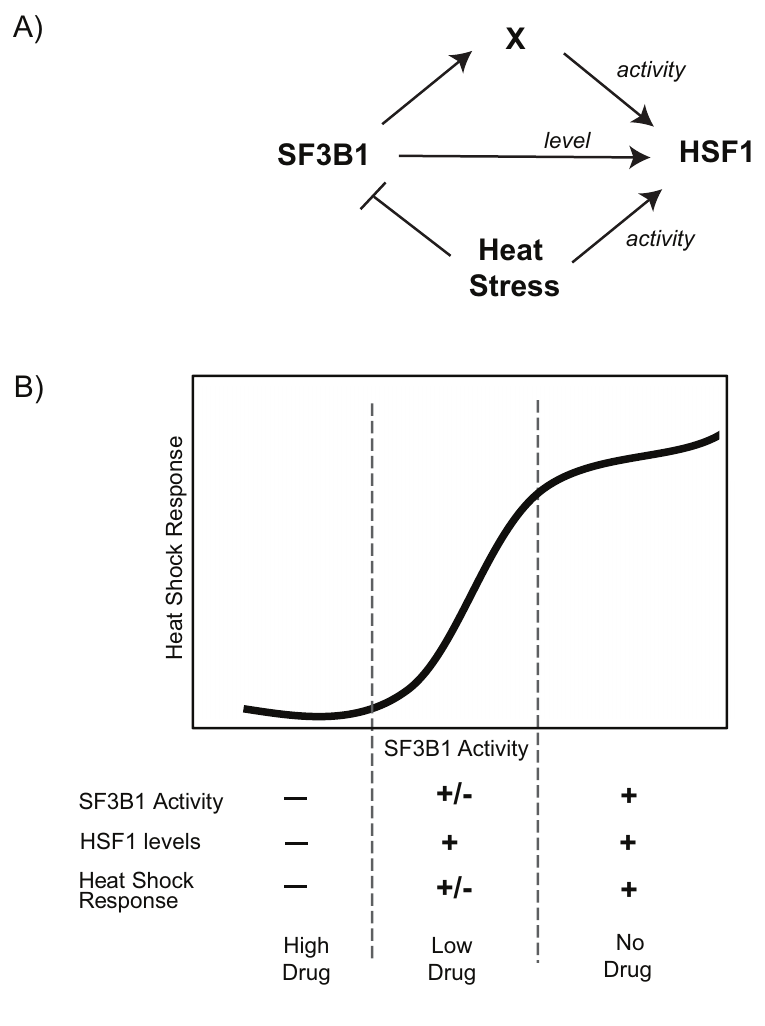
Fig 6. Model. (A) Model figure indicating the role of SF3B1 in regulationof the heat shock response. The central arrow indicatesthat SF3B1 regulatesHSF1 concentration. The upper pathway indicatesa second, indirectpathway where SF3B1 mediatesregulationof HSF1 activity via an unknownfactor X. The bottom pathway indicatesheat shock stress conditionsthat both activate HSF1 activity and inhibit SF3B1. (B) Model figure demonstrating the relationshipbetweenthe heat shock response, SF3B1 activity, and HSF1 levels.